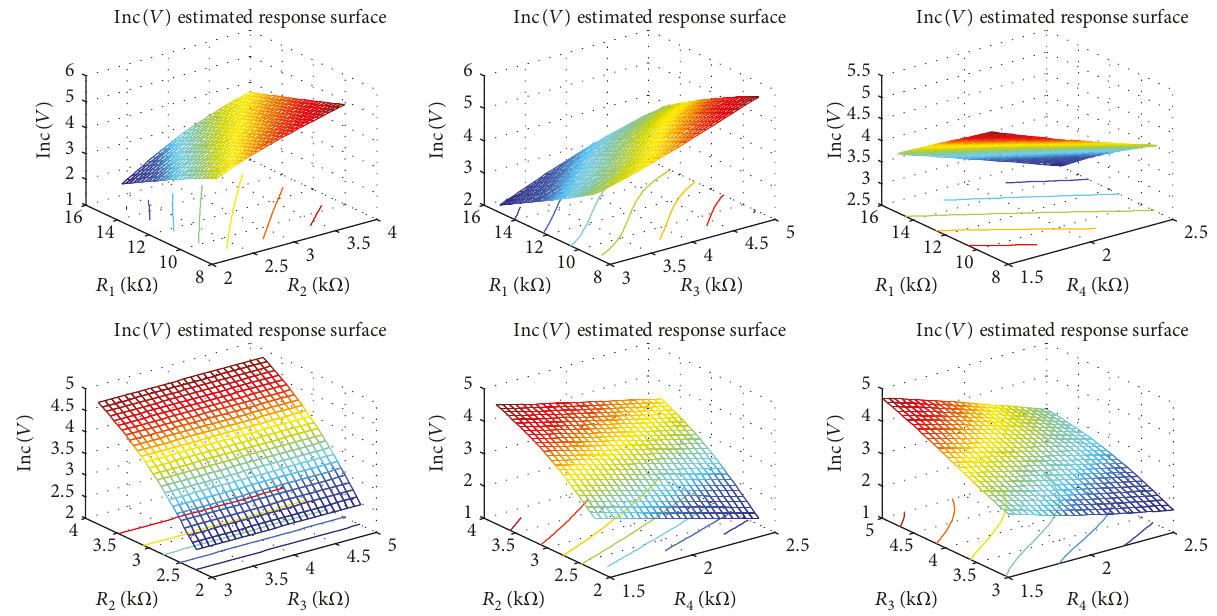
Figure 6: Estimated ANN response surface for the Δ V .